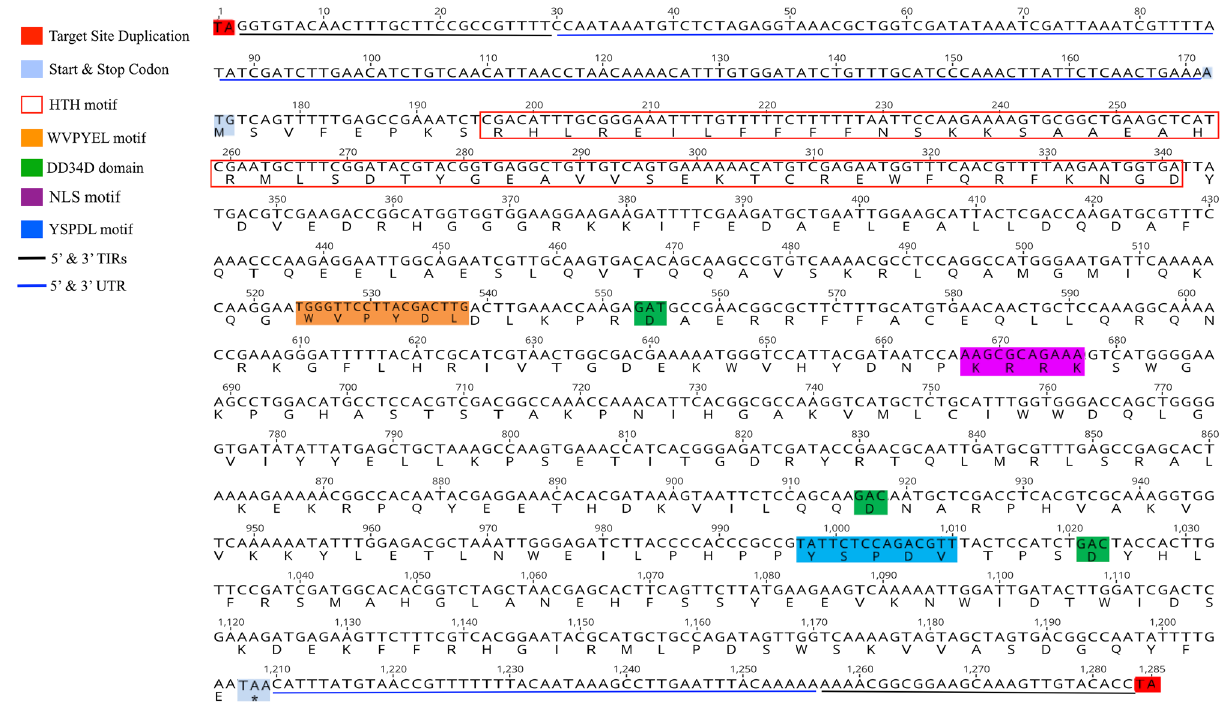
Figure 2. Full length sequence of MLE ( Krmar5 ) from Mauritiana subfamily in Kaburagia rhusicola with slightly modified WVPYE(D)L and YSPDL(V) motifs for